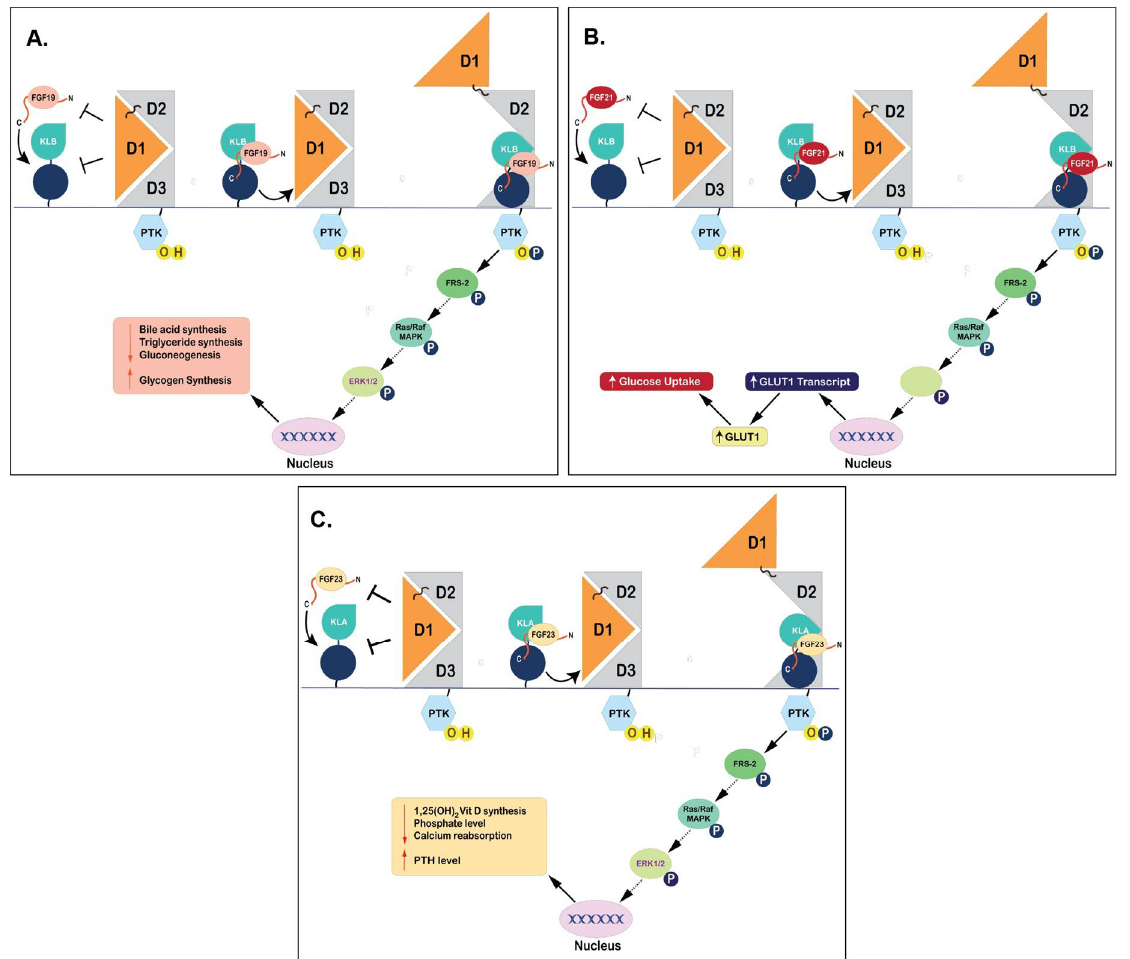
Figure 6. Binding Mechanisms of Endocrine FGFs to FGFR1c and klotho proteins. (Panel- A ): Binding of FGF19 to KLB and FGFR1c that results in subsequent repression of bile acid synthesis. (Panel- B ): Interaction of FGF21 to its receptors (KLB and FGFR1c) and subsequent activation of downstream signaling pathways leading to physiological effects of glucose uptake in adipose tissues. (Panel- C ): Schematic representation of binding of FGF23 to KLA and FGFR1c and induction of downstream signaling pathways to regulate phosphate